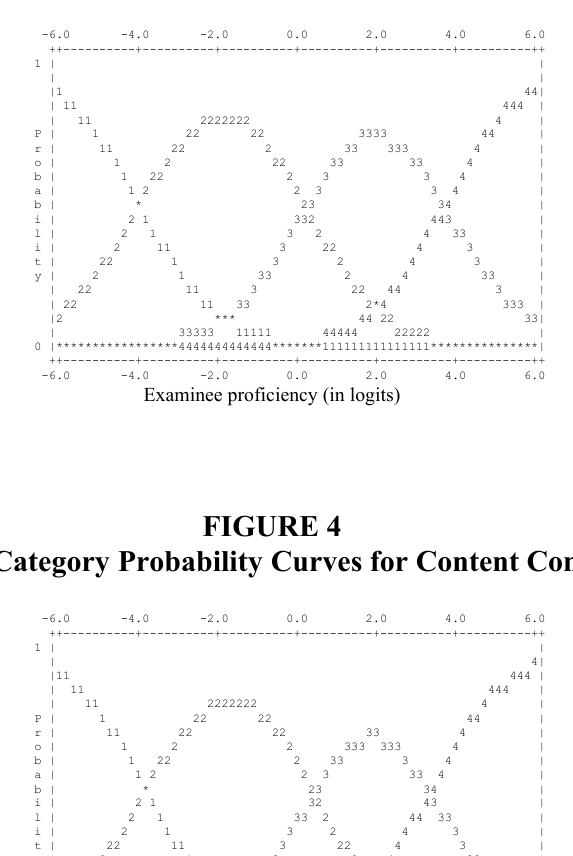
Scale Category Probability Curves for Overall Task Fulfillment